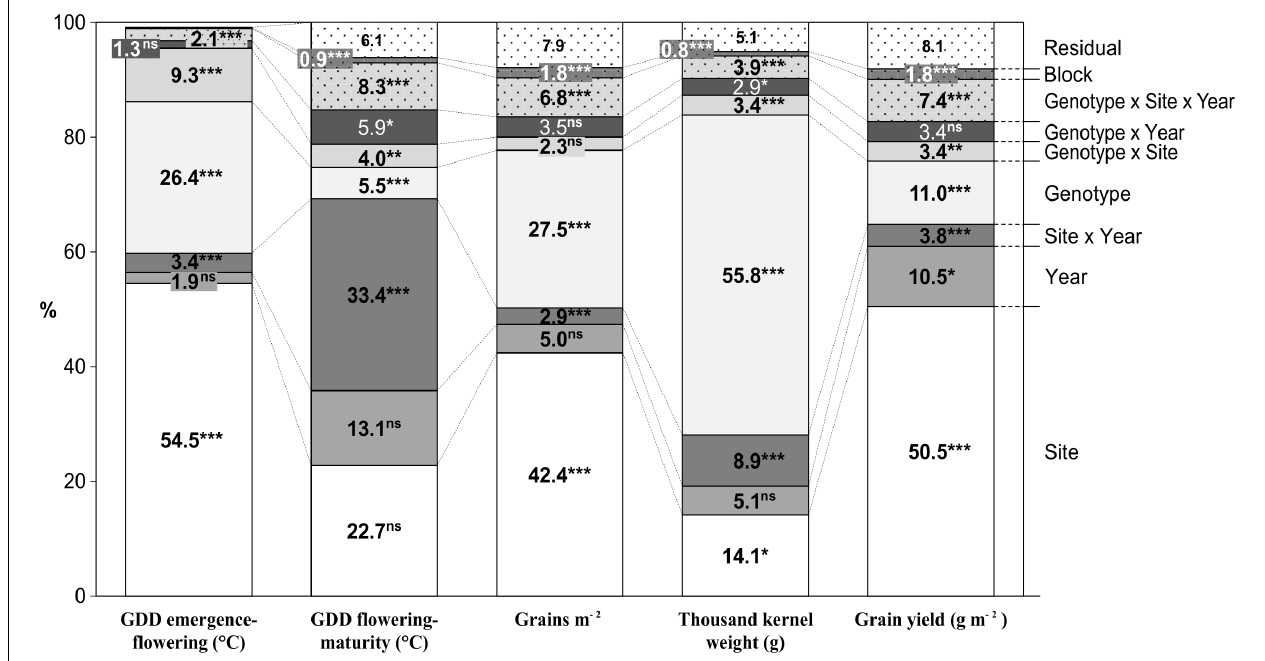
FIGURE 2 | Percentage of the total sum of squares corresponding to the different sources of variation in the ANOVA model obtained from the evaluation of 23 durum wheat genotypes grown in three sites of contrasting latitude during 5 years. ∗ P < 0.05, ∗∗ P < 0.01, ∗∗∗ P < 0.001.